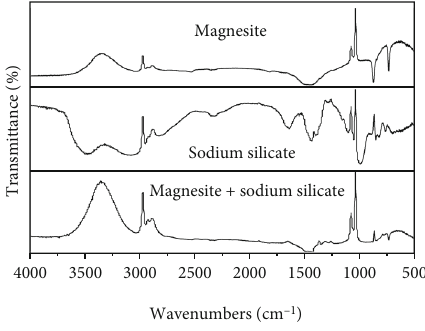
Figure 14: FTIR spectra of magnesite and sodium silicate.